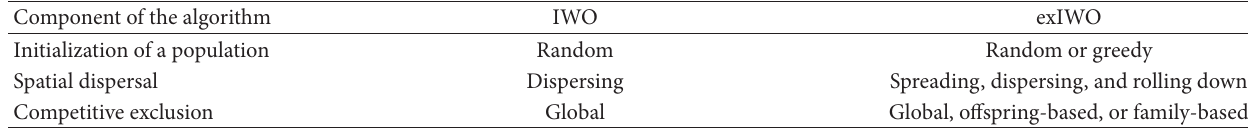
Table 1: Main differences between IWO and